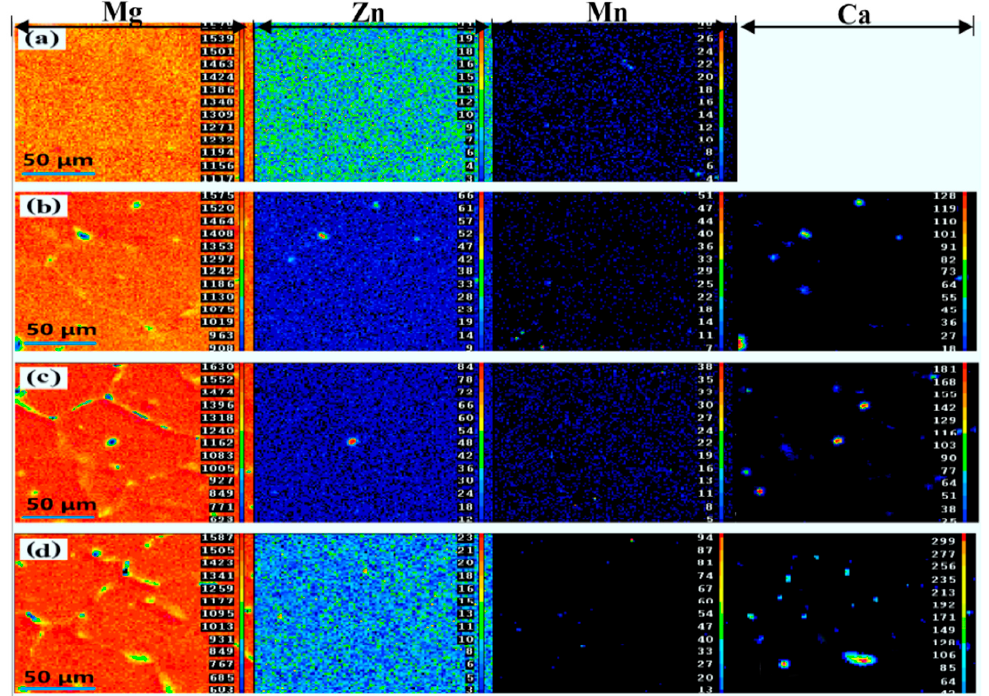
Figure 2. The elements distribution of samples with homogenization treatment: ( a ) MZM; ( b ) MZM-0.38% Ca; ( c ) MZM-0.76% Ca; and ( d ) MZM-1.10% Ca.